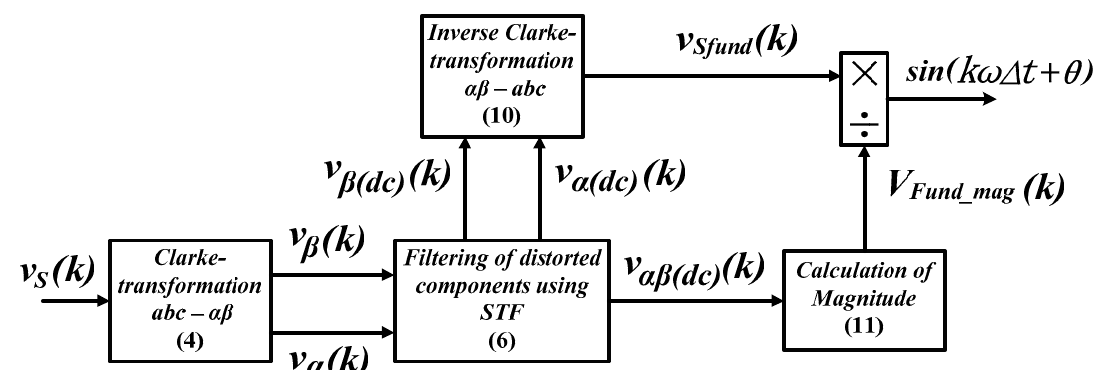
Figure 9. Control structure of fundamental component extraction technique with an integrated self-tuning filter (STF) [59,60].